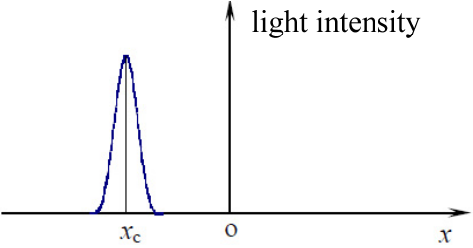
Figure 2. Light intensity distribution of digital sun sensor with single slit.